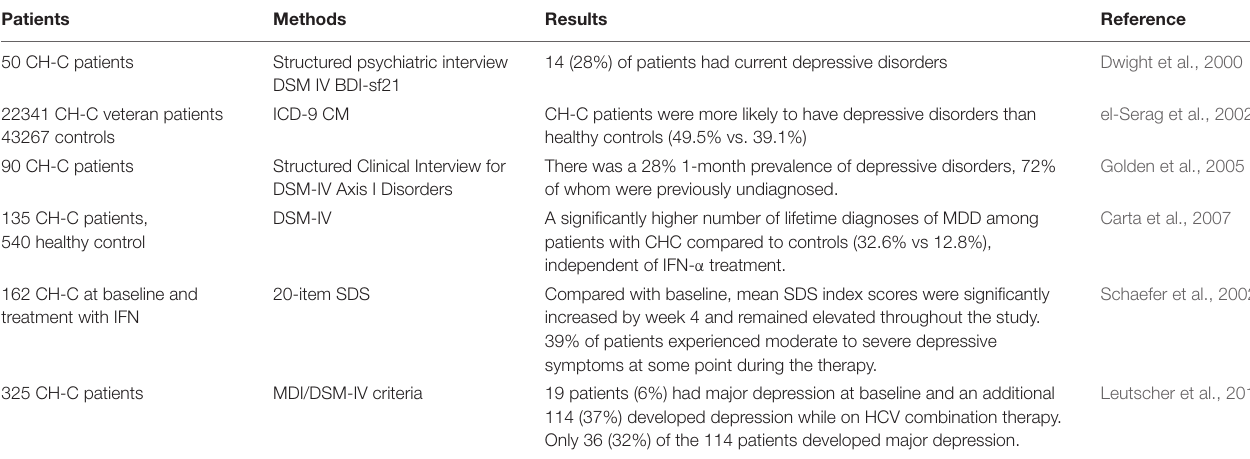
TABLE 2 | The prevalence of depression in patients with